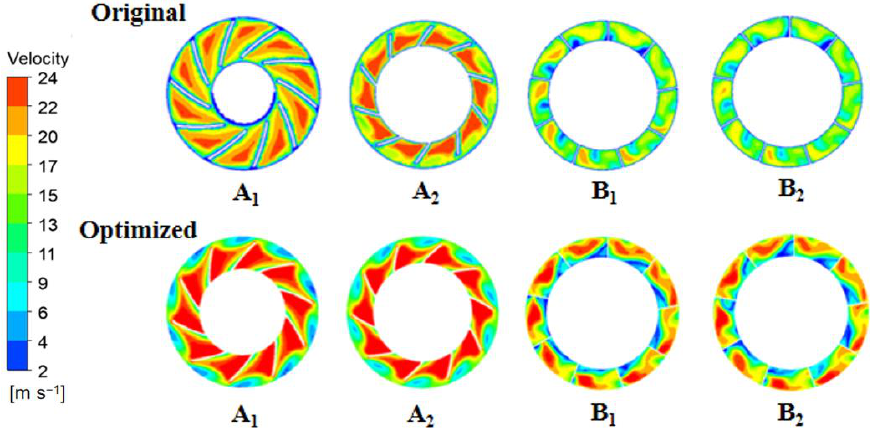
Figure 17. Velocity distribution of different flow direction sections before and after optimization.